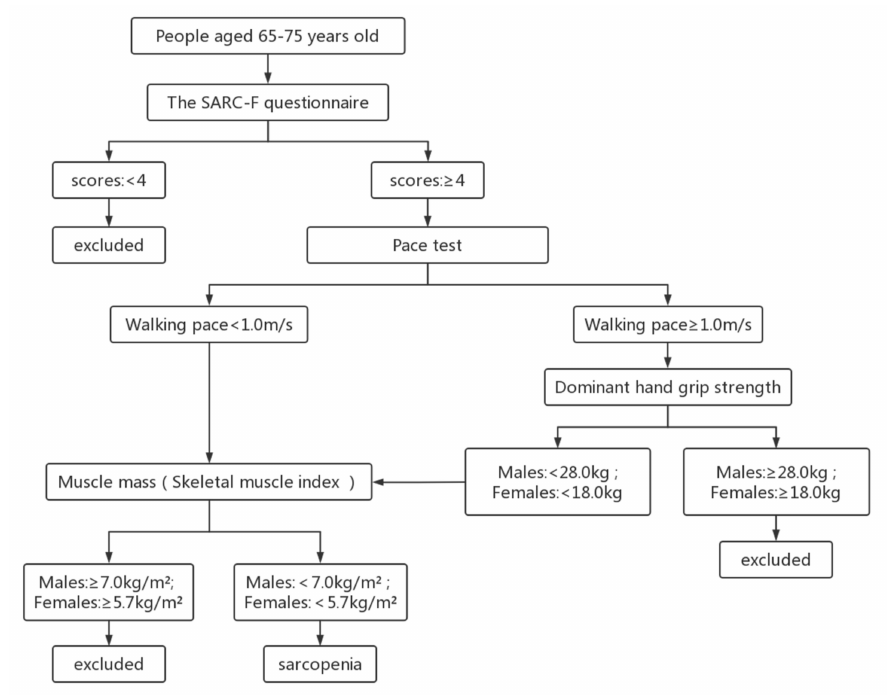
Figure 1. Assessment and screening process for